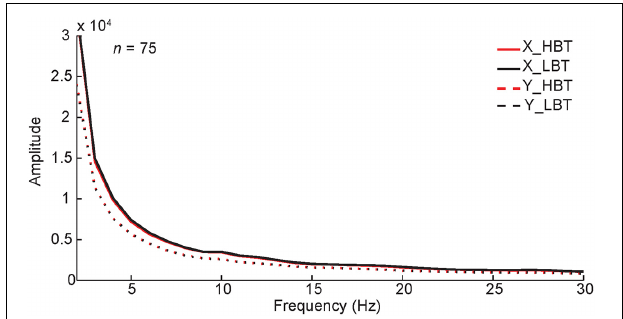
FIGURE 8 | Monkeys’ eye movements in HBT and LBT. The power spectrum of the monkeys’ horizontal (X) and vertical (Y) eye positions in single trials, during baseline period ( − 300–0ms), is shown. To test if the results were different between HBT and LBT we performed a permutation test, separately for horizontal and vertical positions. In the permutation test, the trials were randomly assigned to HBT and LBT while keeping the number of trials in each condition unchanged. We compared the experimental spectral power difference with the distribution of spectral power differences obtained from 1000 such permutations. The results showed that the difference between the spectral power of HBT vs. the spectral power of LBT, for the horizontal or vertical positions, was not significant ( P > 0 . 05).